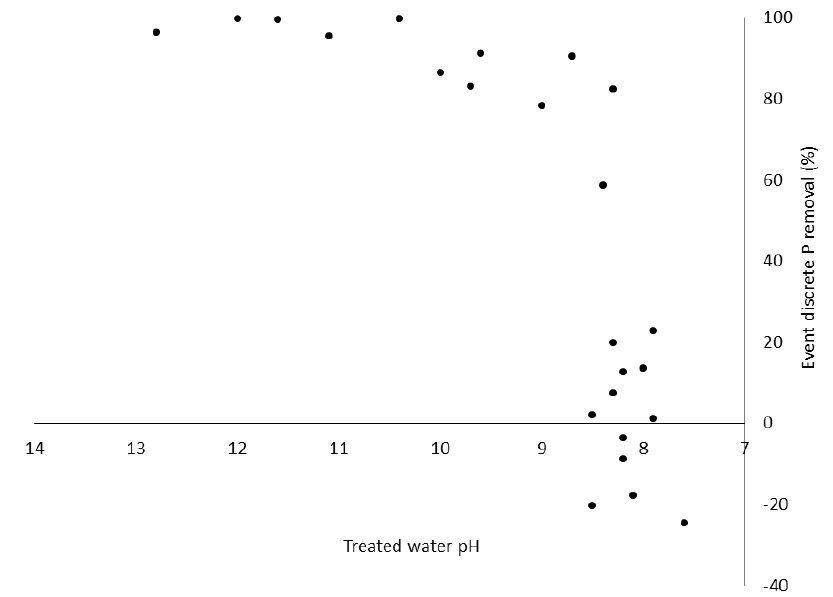
Figure 8. Impact of treated water pH on discrete dissolved phosphorus (P) removal for the subsurface tile drain P removal structure shown in Figure 1.